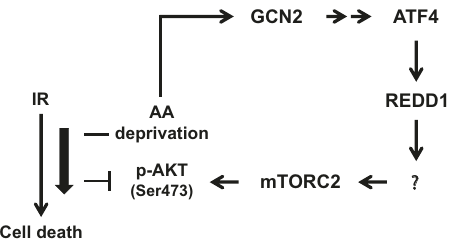
Fig. 9 Proposed mechanism by which amino acid deprivation induces AKT activation necessary for non-small cell lung cancer cell survival. Amino acid deprivation induces REDD1 expression by GCN2/ATF4 pathway activation. REDD1 induction by amino acid deprivation in turn activates the mTORC2/AKT axis, which is required for cell survival. Disruption of REDD1 inhibits AKT phosphorylation by IR and glutamine deprivation and enhances glutamine-deprived cell sensitivity to IR. AA: amino acid, IR: ionizing